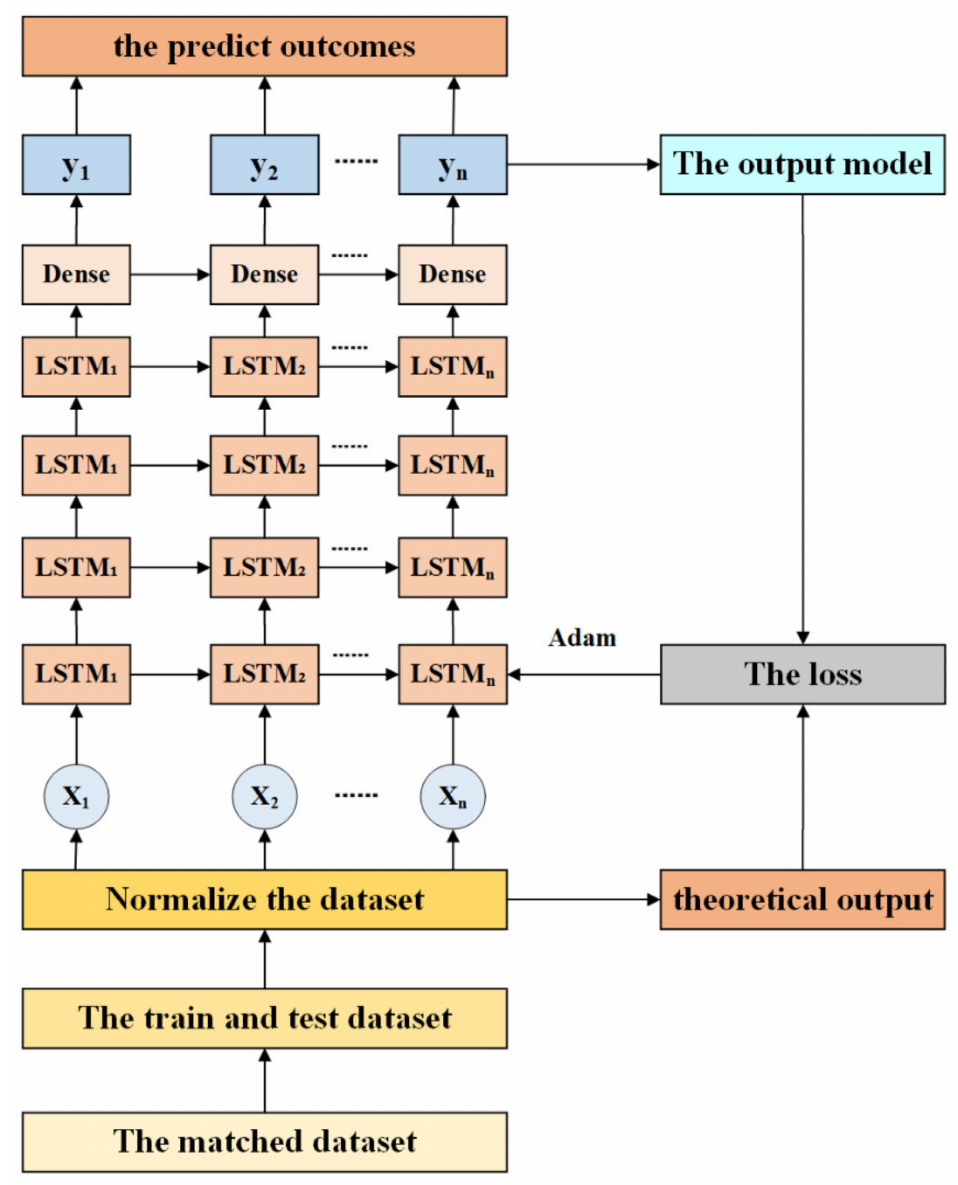
Figure 3. The LSTM block